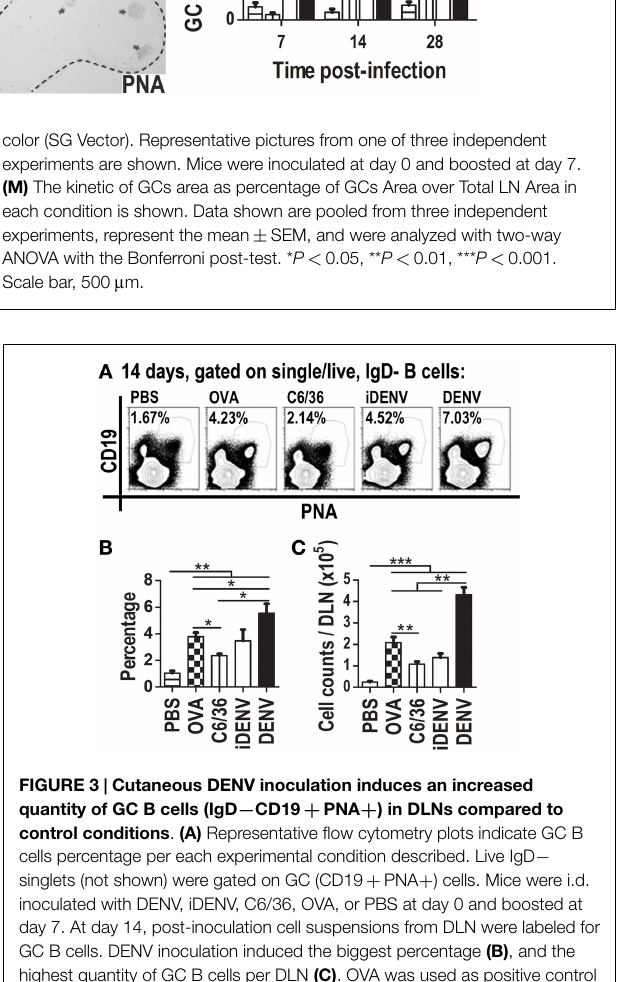
FIGURE 3 | Cutaneous DENV inoculation induces an increased quantity of GC B cells (IgD (cid:0) CD19 + PNA + ) in DLNs compared to control conditions . (A) Representative flow cytometry plots indicate GC B cells percentage per each experimental condition described. Live IgD − singlets (not shown) were gated on GC (CD19 + PNA + ) cells. Mice were i.d. inoculated with DENV, iDENV, C6/36, OVA, or PBS at day 0 and boosted at day 7. At day 14, post-inoculation cell suspensions from DLN were labeled for GC B cells. DENV inoculation induced the biggest percentage (B) , and the highest quantity of GC B cells per DLN (C) . OVA was used as positive control for GCs induction. Data shown are pooled from three to six independent experiments, represent the mean ± SEM, and were analyzed with unpaired two-tailed Student’s t -test. * P < 0.05, ** P < 0.01, *** P <